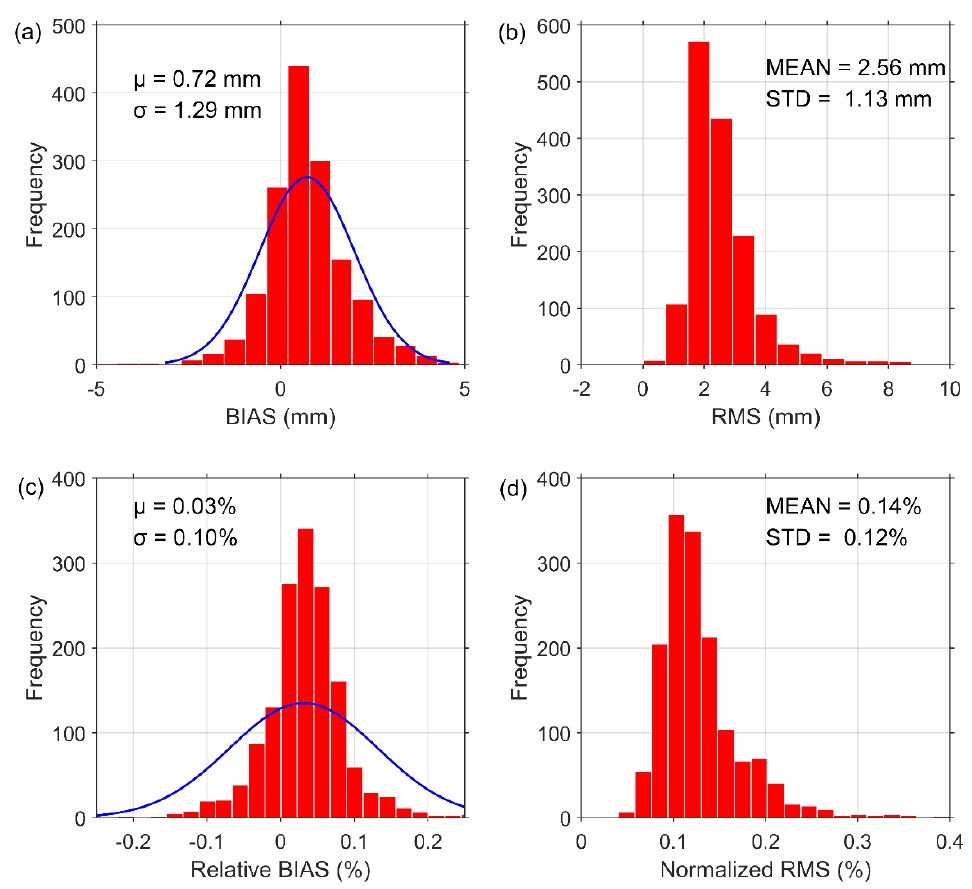
Figure 4. Frequency histograms and normal fittings of bias ( a ), RMSE ( b ), relative bias ( c ), and normalized RMSE ( d ) of 1534 stations during 1994–2020.